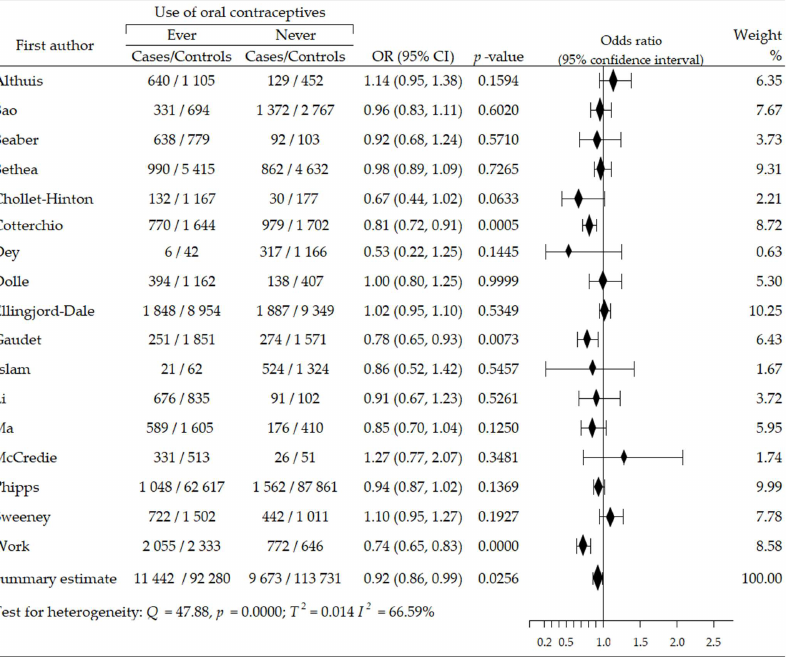
Figure 2. Forest plot and summary odds ratios on the association between risk of ER+BrCa and ever-use of oral contraceptives. Note: black diamonds represent the effect sizes; the horizontal lines denote the 95% confidence interval.